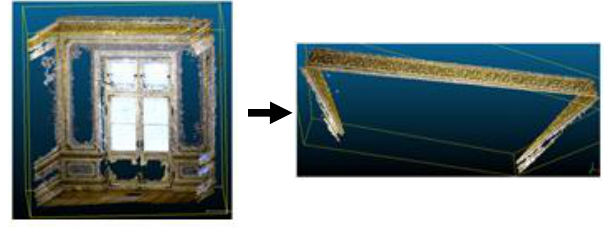
Figure 8. Limiting the point cloud from image matching to under-ceiling gildings.